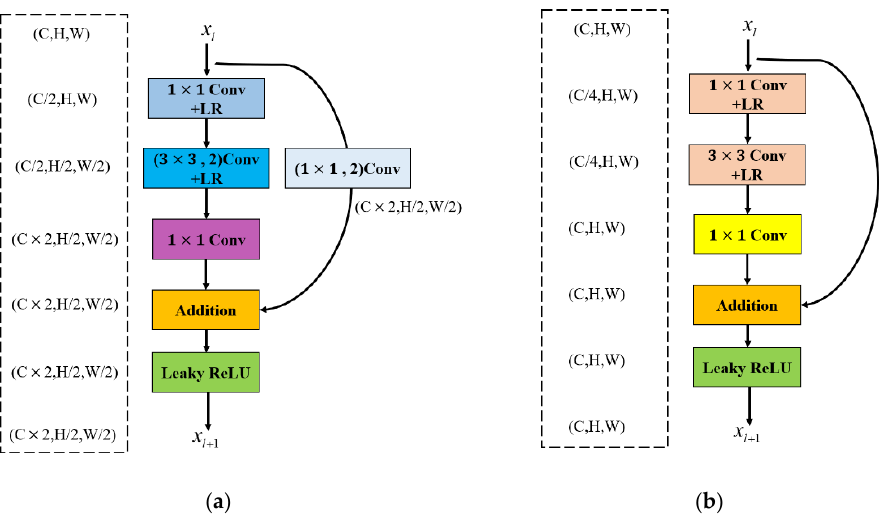
Figure 4. Residual structures used in discriminator. ( a ) “ResBlock Downsample” block. ( b ) Traditional residual block.